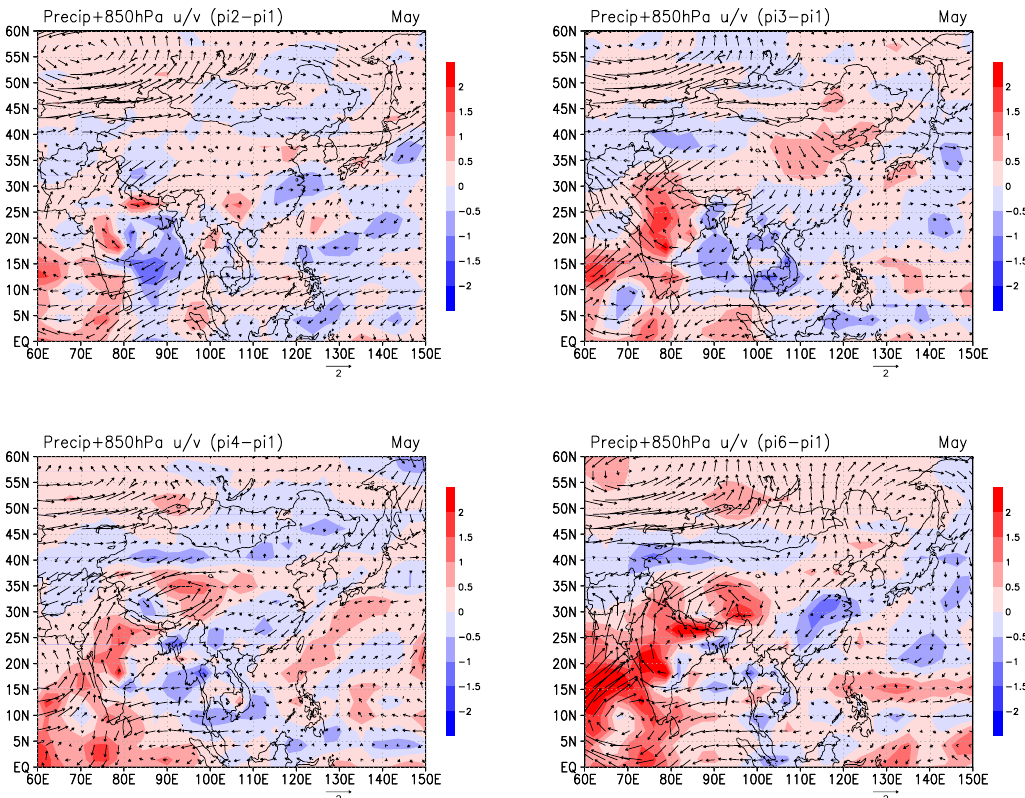
Fig. 15. Spatial distribution of changes for precipitation (shaded, Unit: mmday − 1 ) and 850hPa wind fields (vector, Unit: ms − 1 ) averaged for May for pi2-pi1 ( a , induced by CO 2 increase), pi3-pi1 ( b , induced by BC+OM in atmosphere), pi4-pi1 ( c , induced by BC in snow), and pi6-pi1 ( d , induced by CO 2 increase + BC+OM in atmosphere + BC-in-snow),